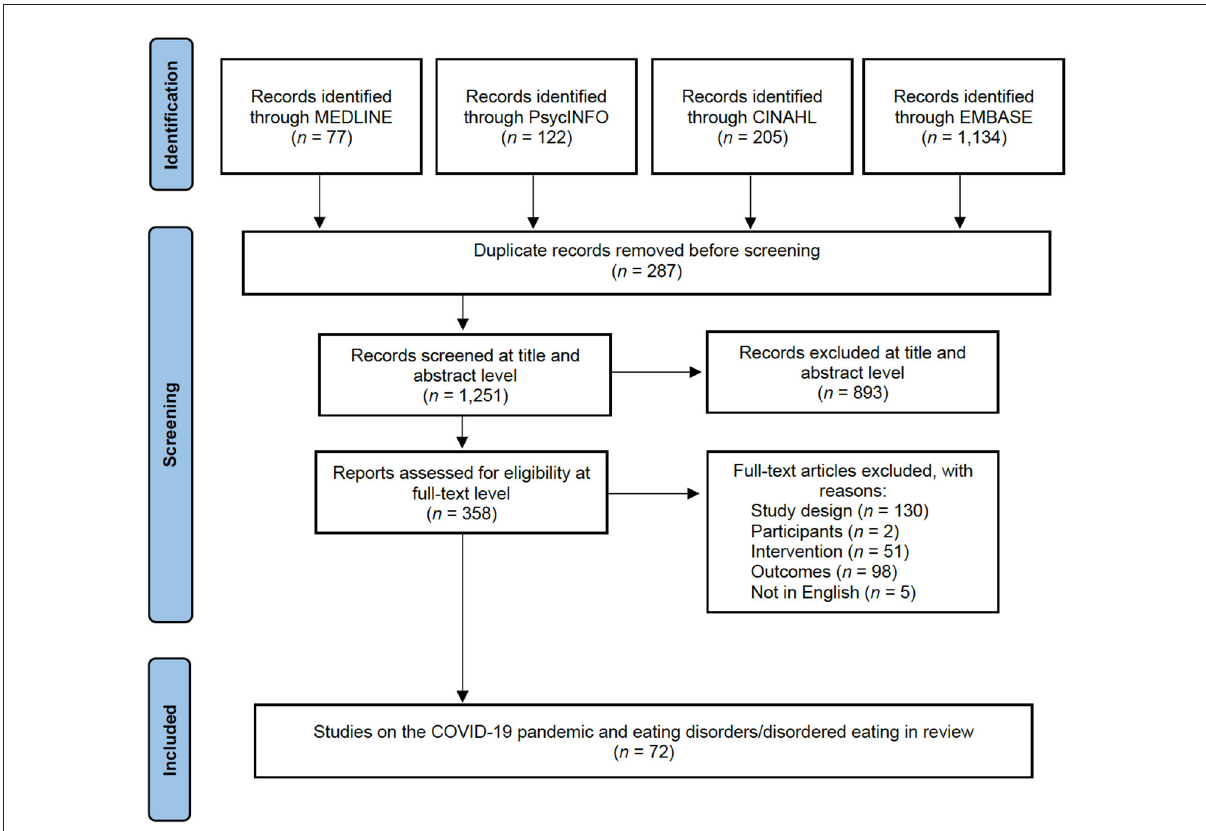
FIGURE1 PRISMA flow diagram of study selection